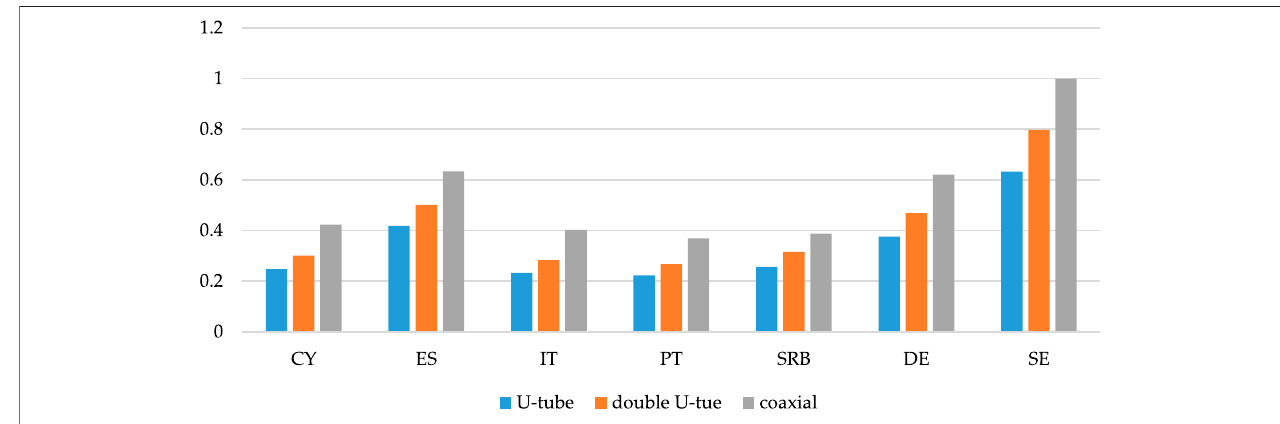
FIGURE 3 | GWP impact for the manufacturing process of the boreholes (GHEs), with the coaxial GHE in SE representing 2,683 kg CO 2 -Eq. per FU.